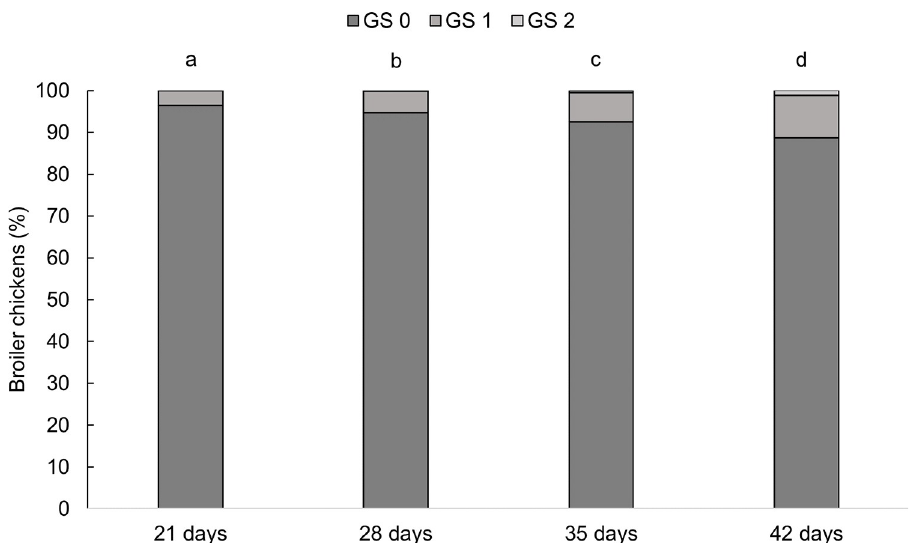
Fig 7. Frequencies (%) of broiler chickens by gait score (GS) at 21, 28, 35, and 42 days of age, n = 16. GS 0: Healthy chickens that exhibited no abnormality when walking, GS 1: Chickens that exhibited difficulty walking in a way that was easily identifiable through observation, and GS 2: Chickens exhibiting severe issues walking [45]. Ages without an uncommon superscript ( a–d ) differed at P < 0.05.